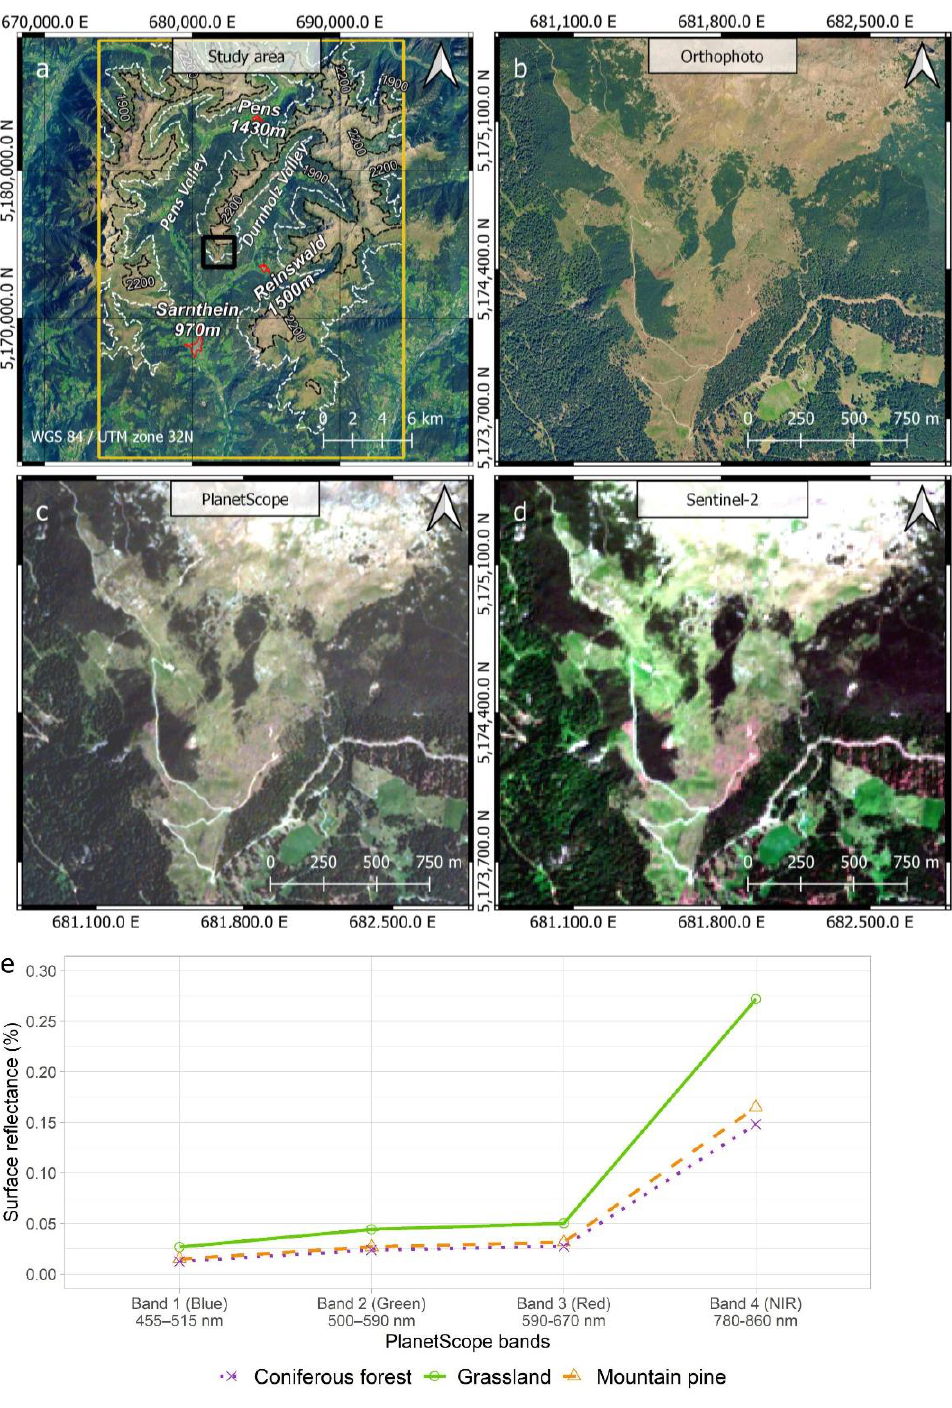
Figure 2. ( a ) Study area (in yellow) and settlement areas (in red) in the Sarntal Alps with a black rectangle showing the extent of the example imagery in ( b – d ). Background: Orthophoto 2020; ( b ) Orthophoto 2020 (20 cm) (Autonomous Province of Bolzano); ( c ) PlanetScope (5 July 2020) (3 m); ( d ) Sentinel-2 (7 July 2020) (10 m) and ( e ) Spectral signatures of grassland, mountain pines and coniferous forest. Spectral signatures are mean reflectance values from reference polygons within the extent of b – d based on PlanetScope bands (5 July 2020).